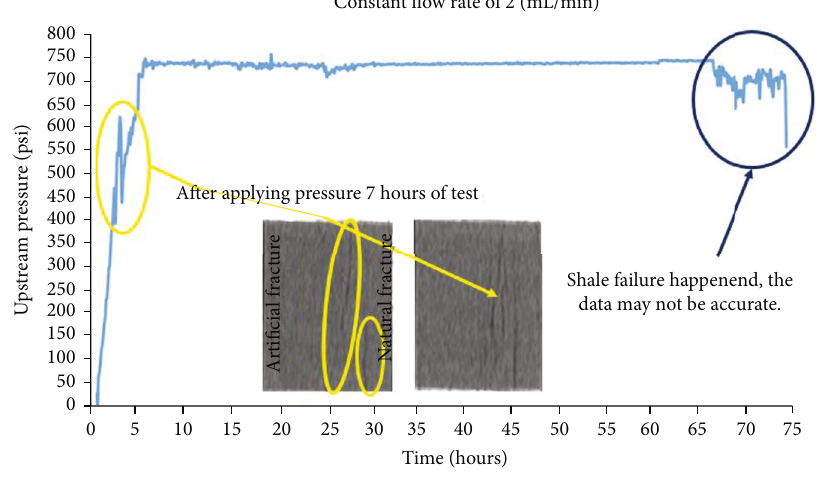
Figure 21: One testing result from Liu and Sheng